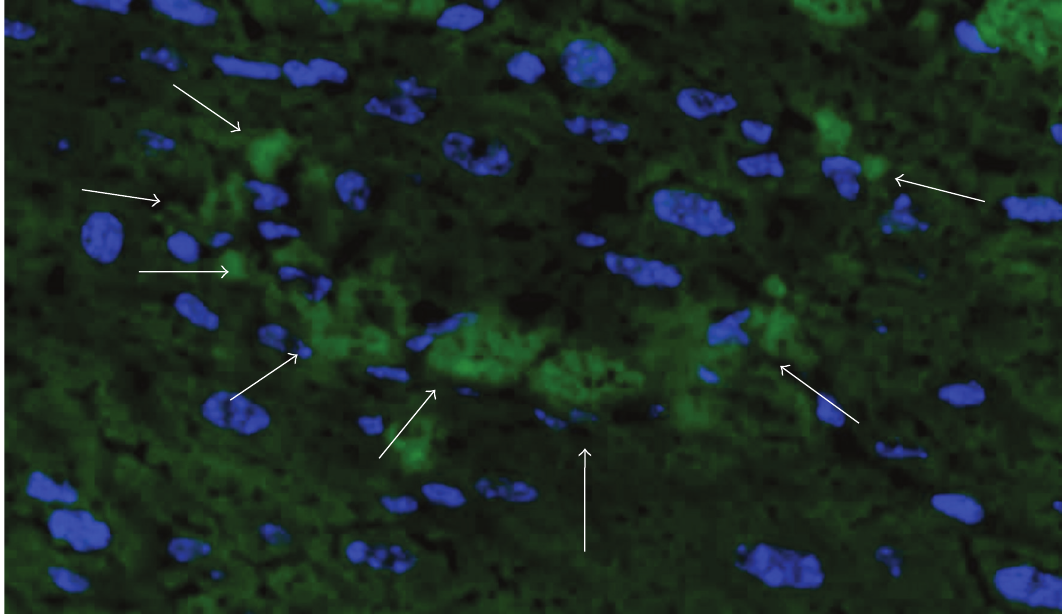
Figure 3: Immunodetection of engrafted rat hepatocytes in Nude mouse liver (original magnification × 40), 21 days after cell transplantation, treated weekly with repeated doses of Jo2 (250 μ g/kg). Blue: Nuclei staining (Hoechst 33342), green: positive CMH class I signal, white arrow: rat